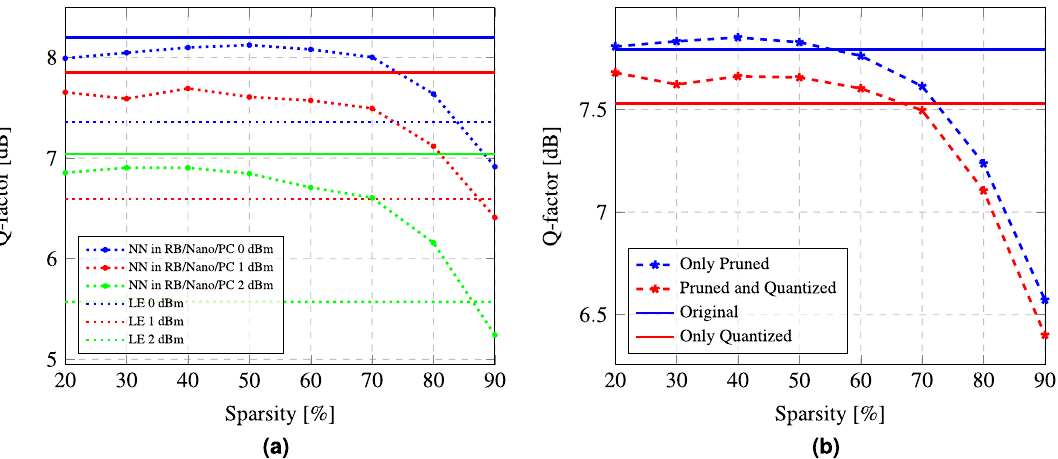
Figure 3. ( a ) Q-factor achieved for pruned and quantized models versus the level of sparsity for datasets corresponding to three launch powers: 0 dBm, 1 dBm, and 2 dBm; The solid lines correspond to the Q-factor achieved by the original model. The dashed lines show the Q-factor when only linear equalization (LE) is implemented. ( b ) Q-factor achieved after pruning compared to the one achieved after both pruning and quantization, for different levels of sparsity and for a dataset corresponding to the 1 dBm launch power. The blue and red solid lines correspond to the Q-factor achieved by the original model and the one achieved by this model after quantization,